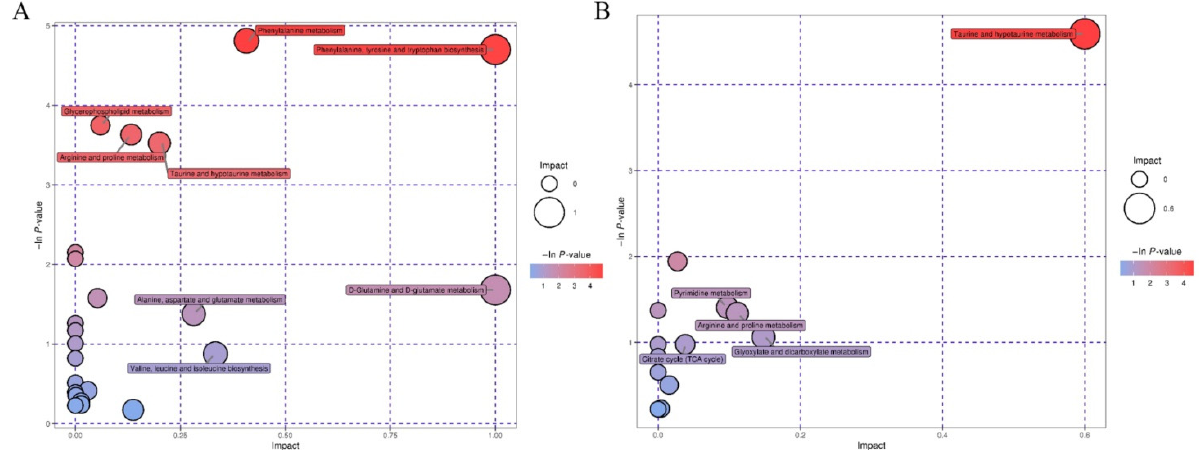
Figure 5. Metabolic pathway profiles of metabolites. The larger the bubble, the greater the influence of the pathway. The red represents a large difference and the white represents a small difference. ( A ) Negative ion mode, ( B ) positive ion mode.